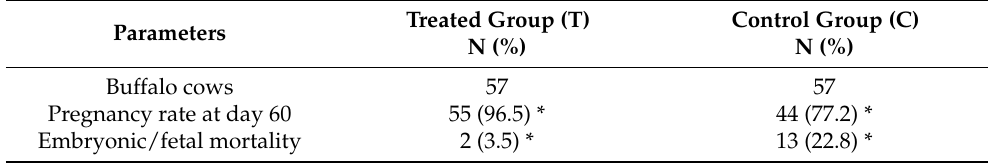
Control Group (C)